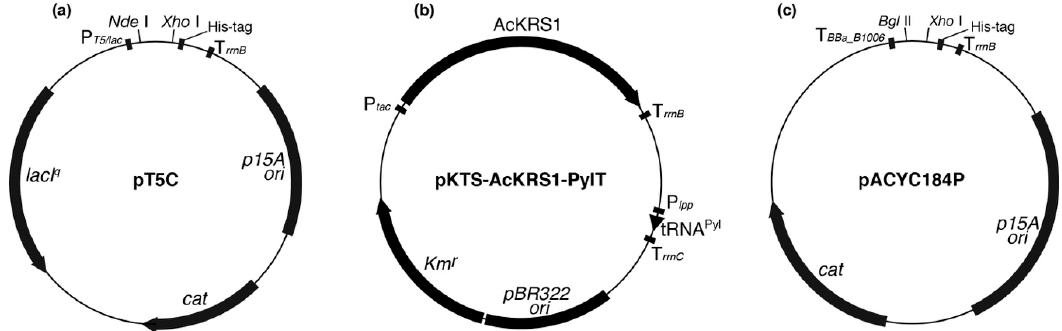
Figure A1. Plasmid maps of ( a ) pT5C, ( b ) pKTS-AcKRS1-PylT, and ( c ) pACYC184P. P T5/lac , P lpp , and P tac indicate promoter. T rrnB and T rrnC , and T BBa_B1006 indicate transcription terminator. The artificial terminator BBa_B1006 blocks intrinsic promoter activity.